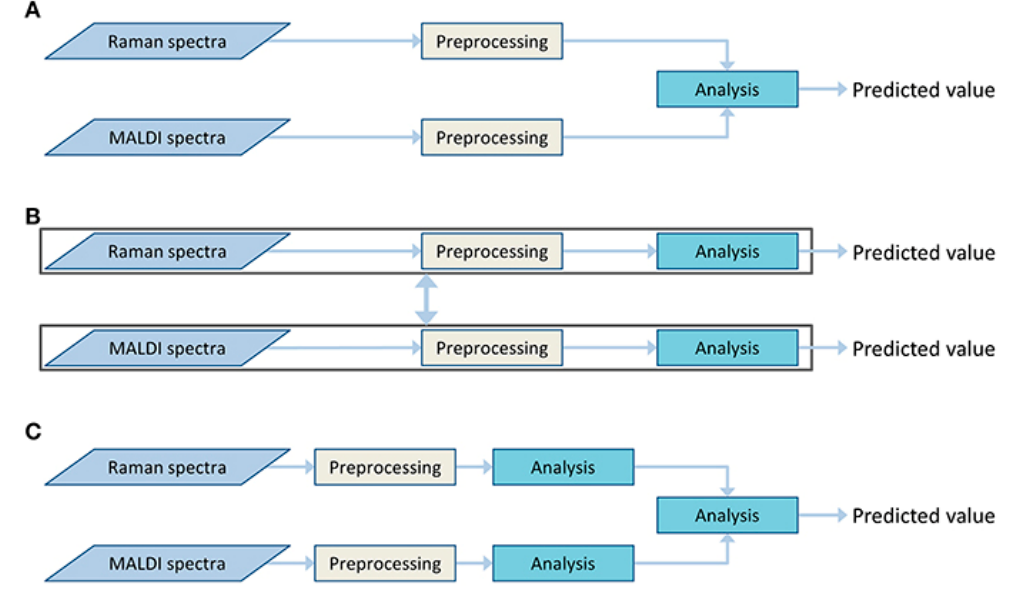
Figure 11. Different types of fusion architectures ( A ) Centralized, in which both types of data are analyzed together after pre-processing. ( B ) Decentralized, where both types of data are analyzed and predicted individually. ( C ) Distributed, where both types of data are analyzed independently and after that both outputs of analysis are analyzed again and a prediction is made. Reprinted with permission from reference [84] , 2021, Ryabchykov et al.